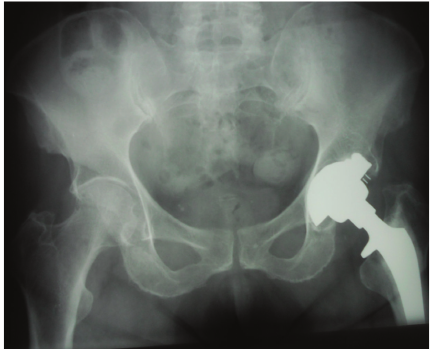
Figure 2: Anterior-posterior hip X-rays in patient number 3 after 9 years on Coumadin are unchanged, Ficat stage II.